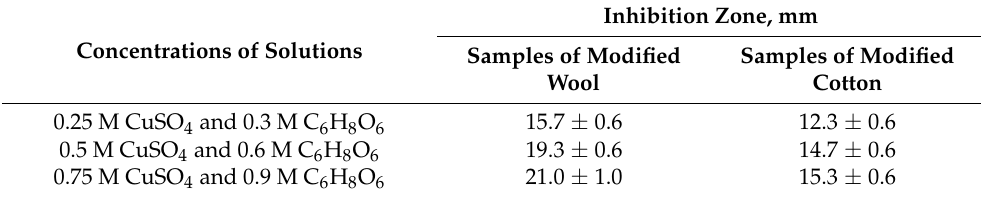
Table 2. Bactericidal activity of modified wool and cotton samples against S. aureus.